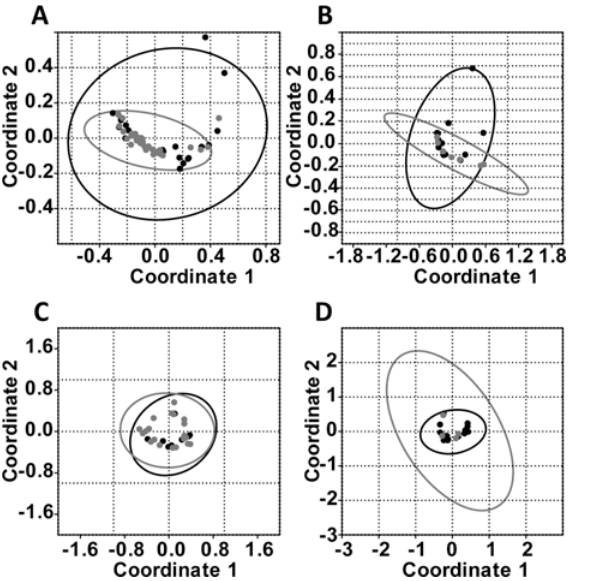
Fig 3. Comparison of bacterial and fungal pattern on pollen collected in rural and urban sample sites. PCoA performed to compare the microbial composition on pollen obtained from rural (grey) and urban areas (black). A) Bacterial composition on birch pollen. B) Bacterial composition on timothy grass pollen. C) Fungal composition on birch pollen. D) Fungal composition on timothy grass